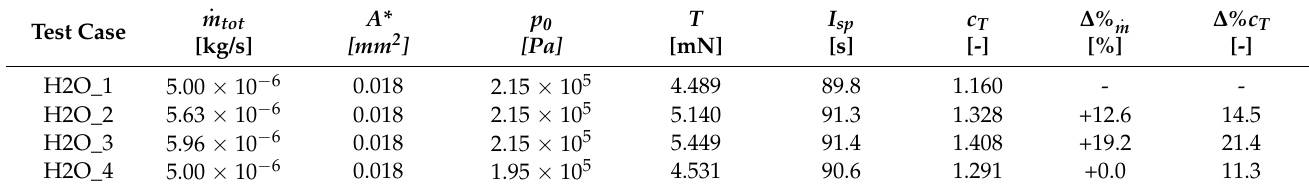
Table 8. Analysis of the flow expansion into the micro-nozzle: water vapor flow.